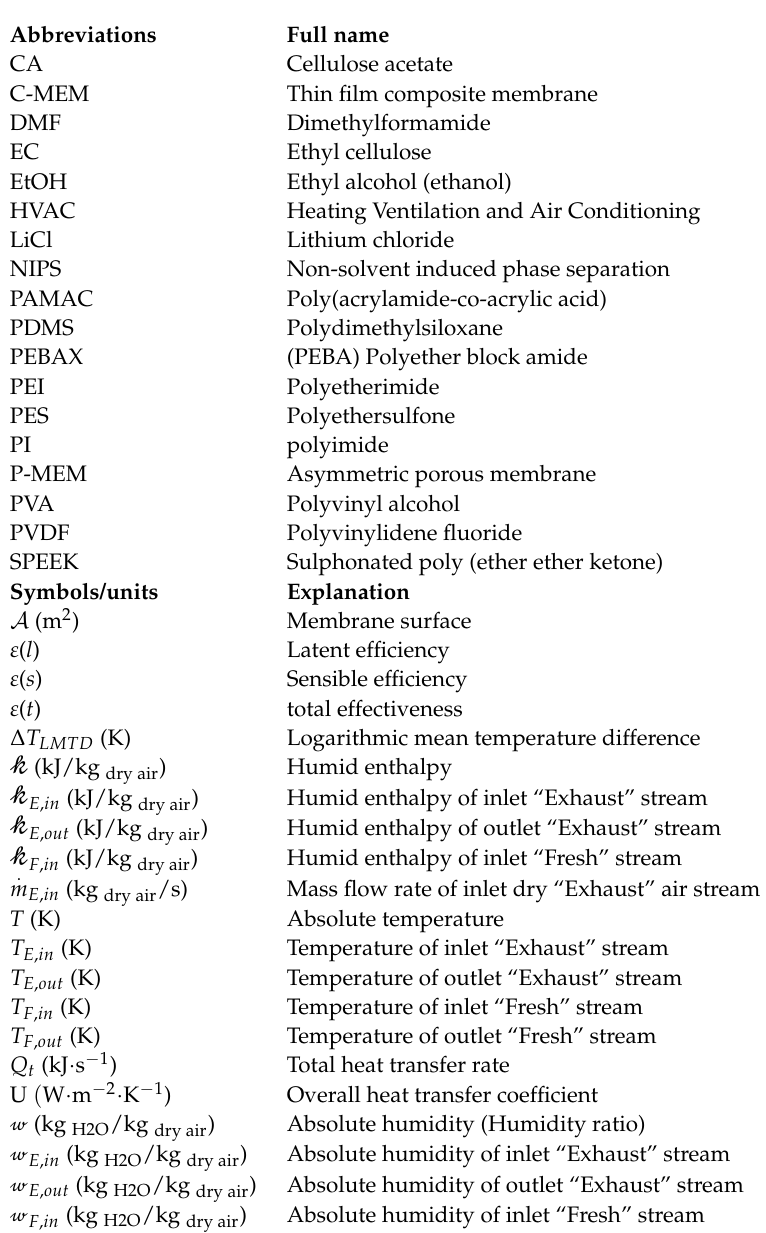
Figure 3. FESEM micrographs of the cross-section of ( a ) kraft paper, ( b ) P-MEM, and ( c ) C-MEM.